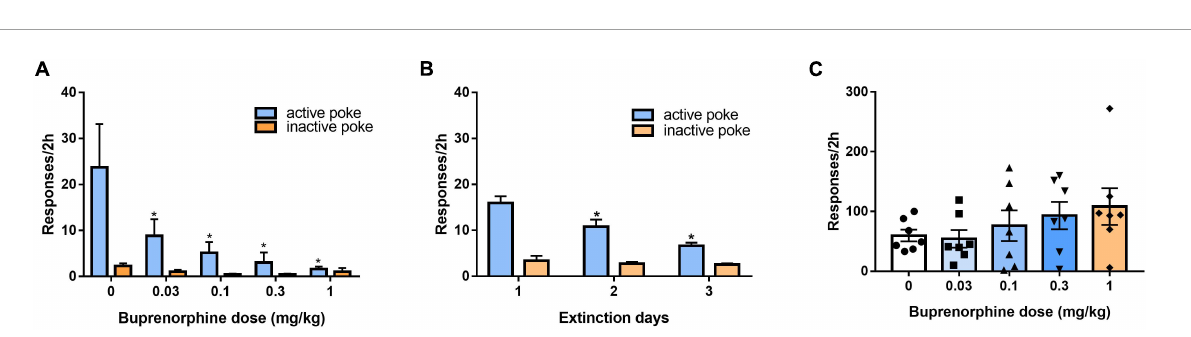
FIGURE4 Effect of buprenorphine on drug-seeking induced by cues. (A) Buprenorphine pretreatment reduced the active responses induced by context during 2 h test in the training chamber after withdrawal from METH self-administration for 14 days. * P < 0.05 vs. vehicle treatment. (B) The rats were extinguished for 3 days. * P < 0.05 vs. first day extinction. (C) The reinstatement induced by conditioned cues. Buprenorphine did not inhibit the active responses induced by conditional stimulus cues during 2 h test. Data are presented as means ± S.E.M.